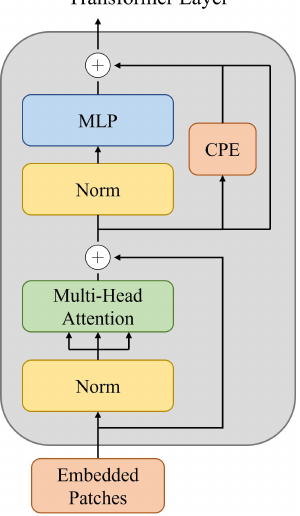
Figure 2. Structure of a transformer layer